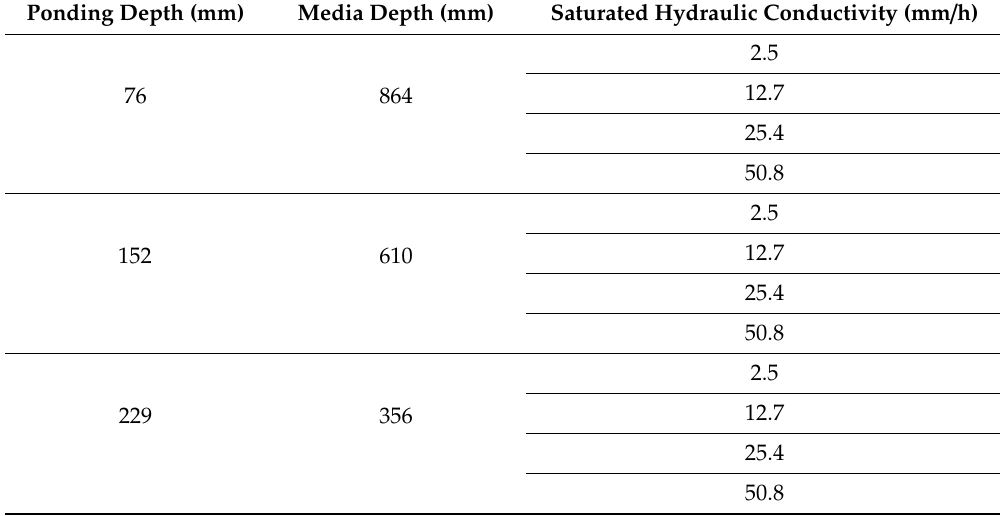
Table 2. Bioinfiltration parameters used to create twelve unique bioinfiltration designs for risk-based